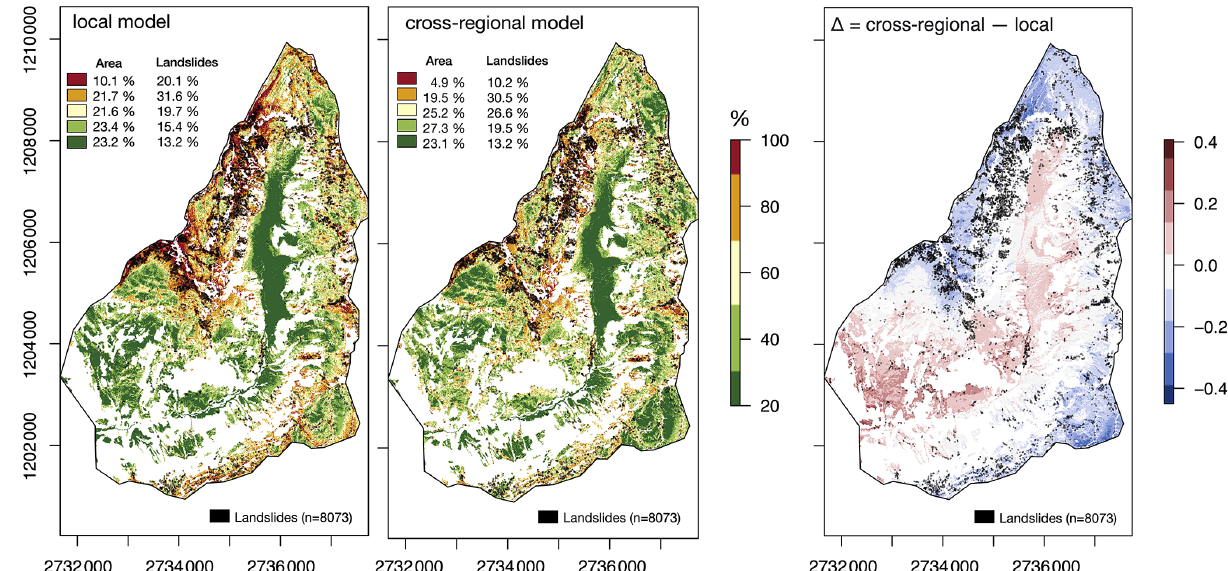
Figure 12. Susceptibility maps for the study site Chrauchtal based on the local model and the cross-regional all-in-one model. The suscep- tibility maps show the probability of shallow landslides occurring at a specific pixel on the map. The difference between the two applied models are shown on the right-hand side. White areas on the map are not grassland and are therefore not